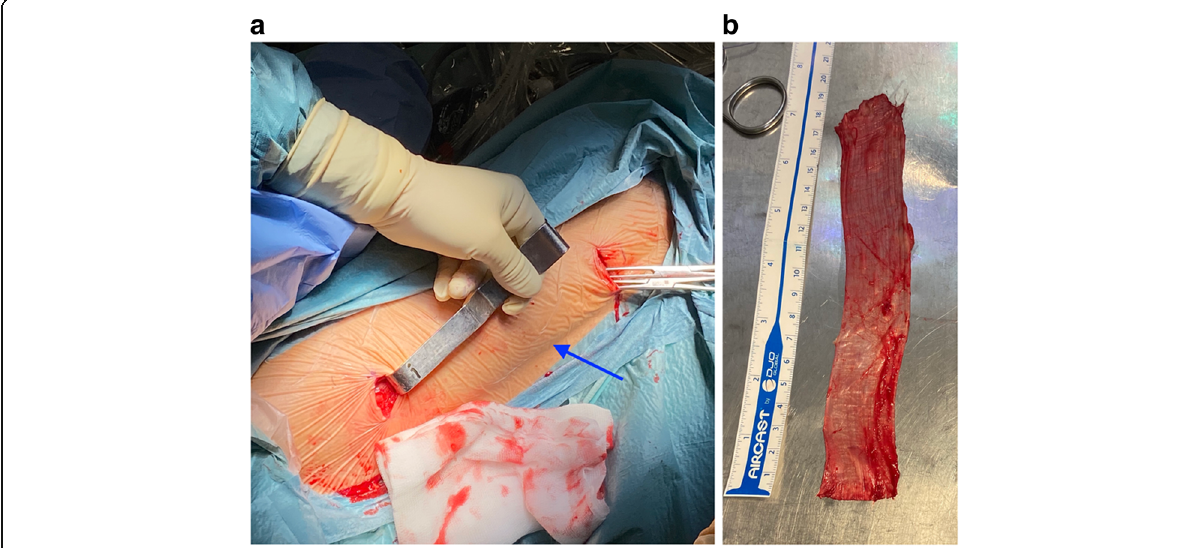
Fig. 1 a Harvesting of the fascia lata autograft from a right thigh through 2 incisions, approximately 4 cm anterior to the crease of the lateral intermuscular septum (arrow): one 15 cm distal to the anterior superior iliac spine and the other 10 cm proximal to the lateral femoral epicondyle. b Autograft should be roughly 20 cm × 3 cm in